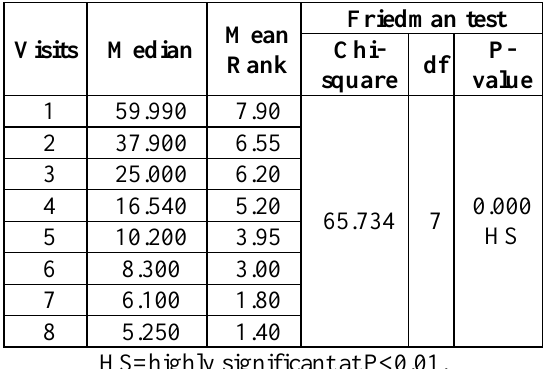
Table 2: Descriptive and statistical test of median percentage of surfaces with bleeding on probing (BOP) score 1 change during visits.